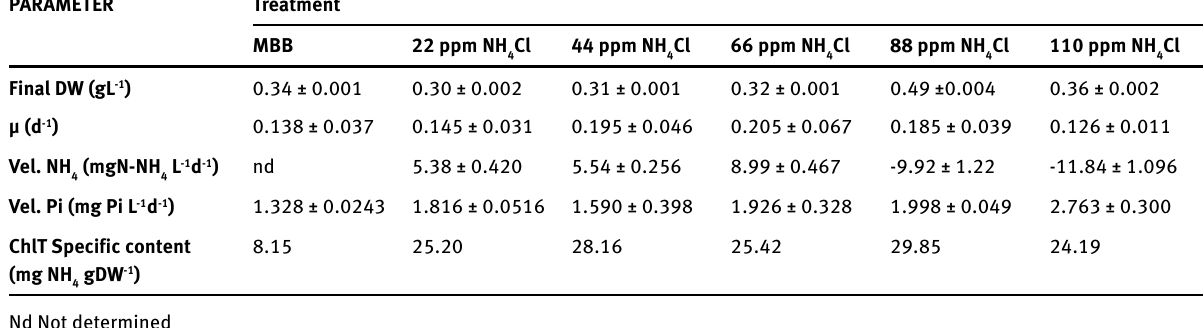
Table 1: Kinetic parameters for C. vulgaris growing at different NH PARAMETER